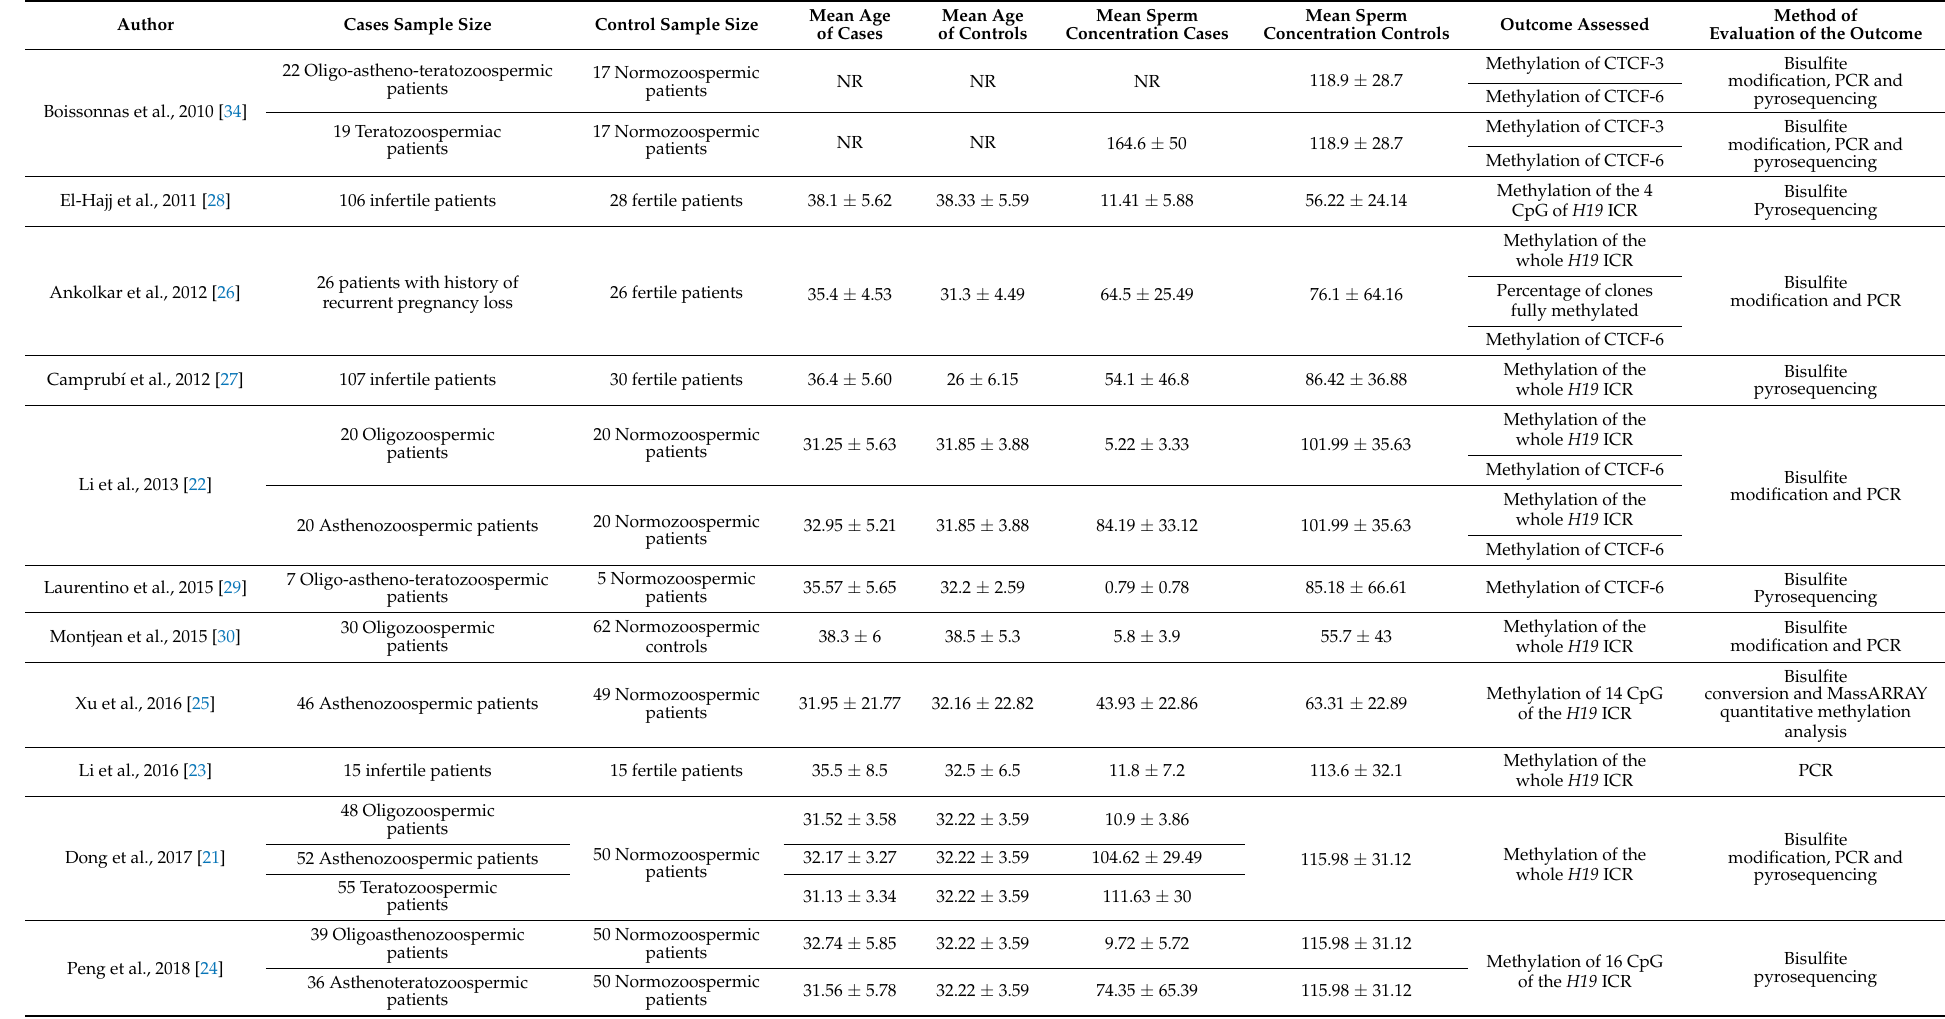
Table 2. Main characteristics of included cross-sectional